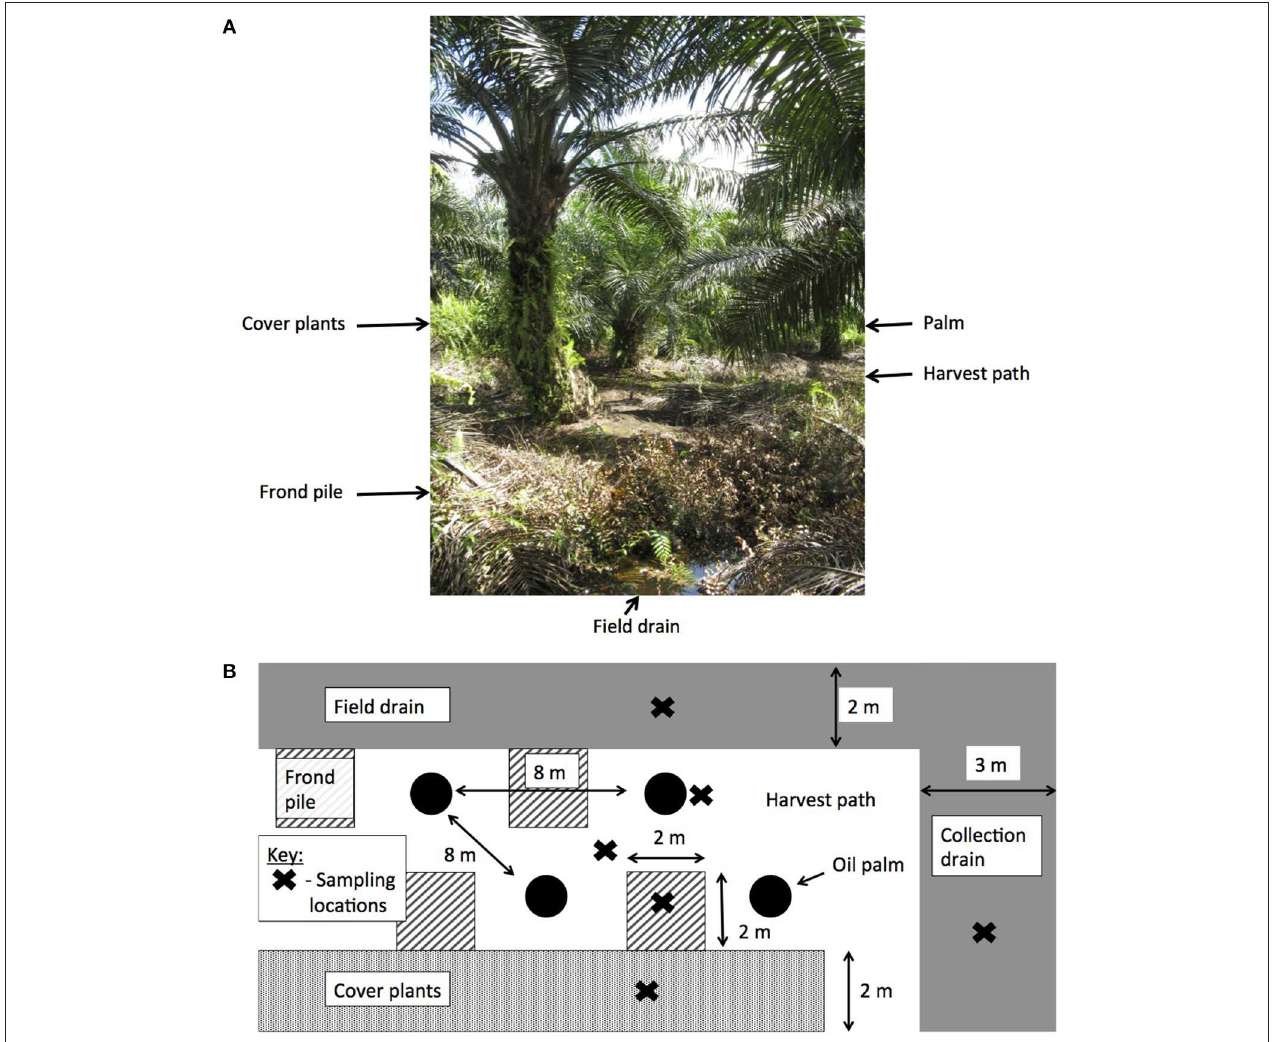
and CH 4 fluxes were collected between June 2015 and May 2016 and stem fluxes were collected from May 2016 to May